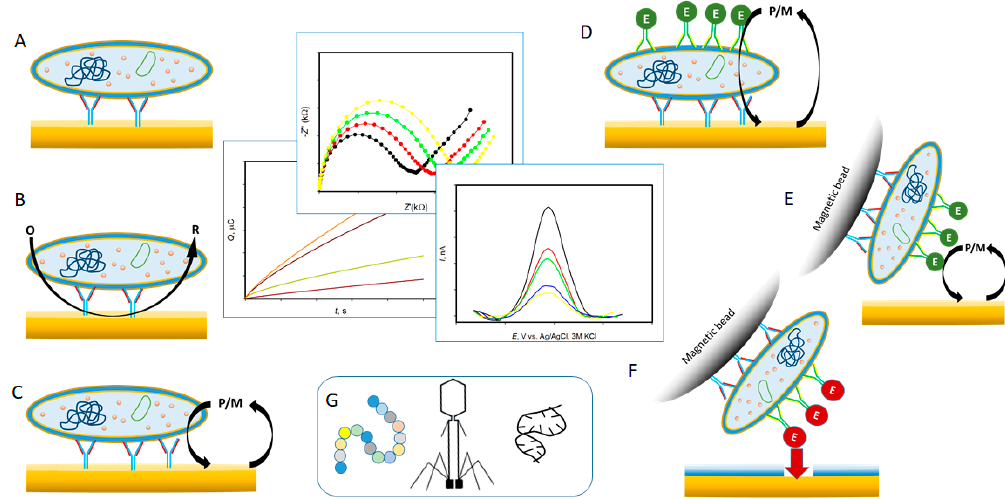
Figure 2. Schematic representation of the typical electrochemical immunosensors. ( A ) In a label-free and indicator-free immunoassay binding of a cell to the Ab-modified surface is detected impedimetrically; ( B ) In the presence of a redox indicator cell binding can also be detected voltammetrically or by chronocoulometry. In ( C ) a redox mediator of cellular metabolism is recycled at the electrode, giving rise to signals associated only with live cells. In ( D ) a bacterial cell is entrapped in an immune-sandwich formed by two Abs on the electrodes surface and labeled with a redox active enzymatic label, whose activity is electrochemically monitored through its substrate recycling at the electrode surface. ( E , F ) represent the sandwich assay adaptation to the magnetic beads-format, in ( F ) redox-inactive enzymatic labels induce changes at the electrode-solution interface that are electrochemically detected. ( G ) In ( A–F ) designs elements alternative to Ab can be used: peptides, phages and aptamers.